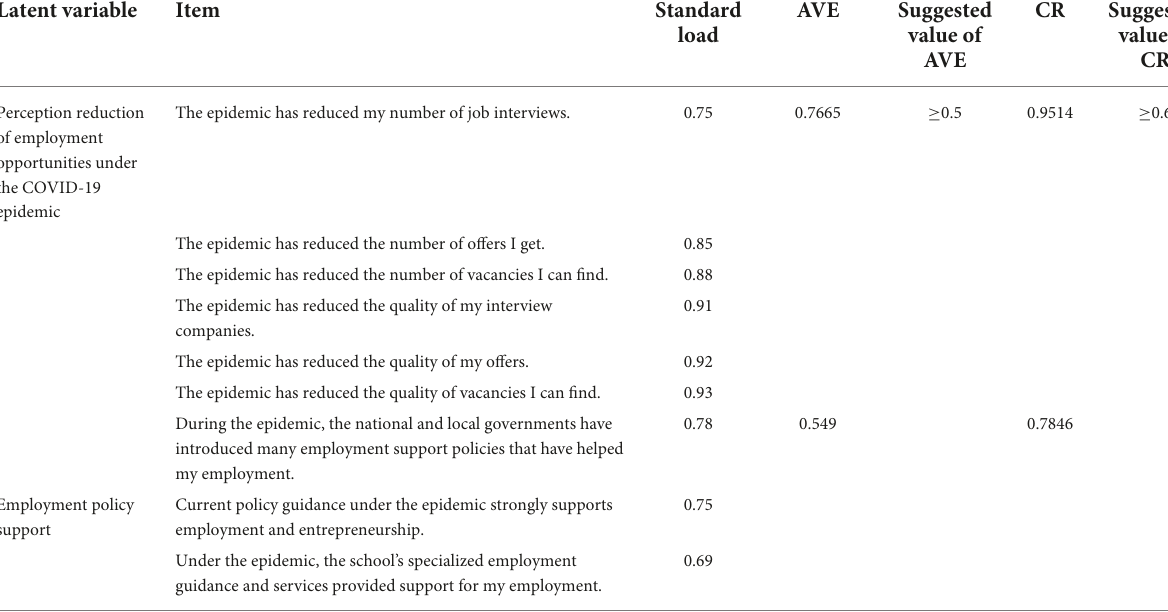
TABLE 1 Results of confirmatory factor analysis of self-compiled scale ( n = 408).